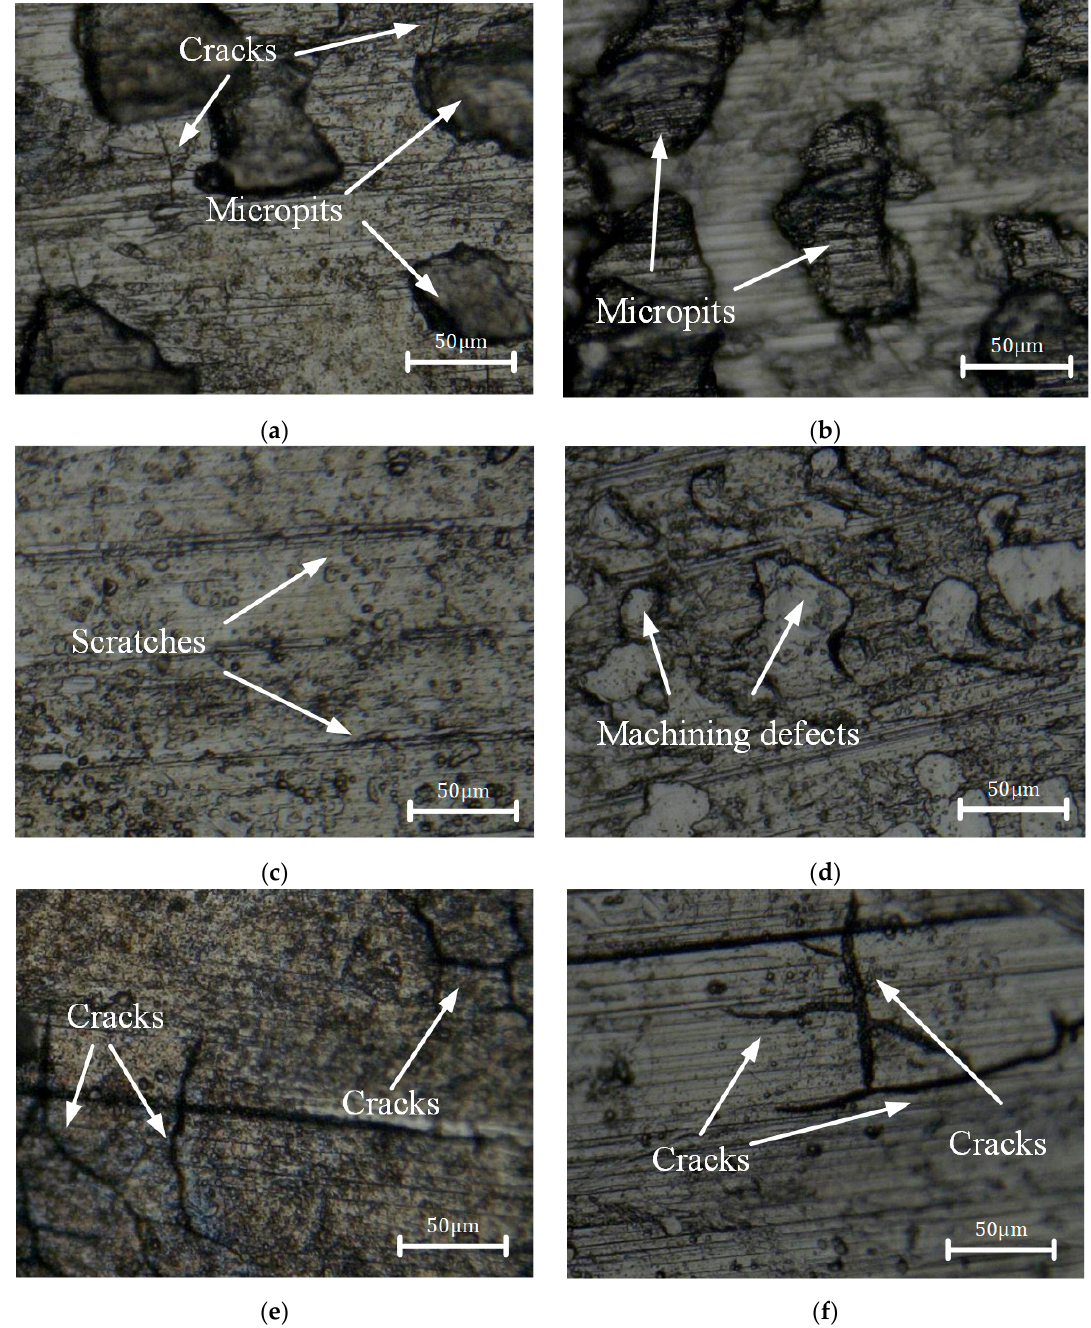
Figure 10. Cracks of the machined surface after multi-pass turning: ( a ) single-pass turning of T3, ( b ) single-pass turning of T5, ( c ) double-pass turning of T8, ( d ) double-pass turning of T10, ( e ) triple- pass turning of T13, ( f ) triple-pass turning of T15.